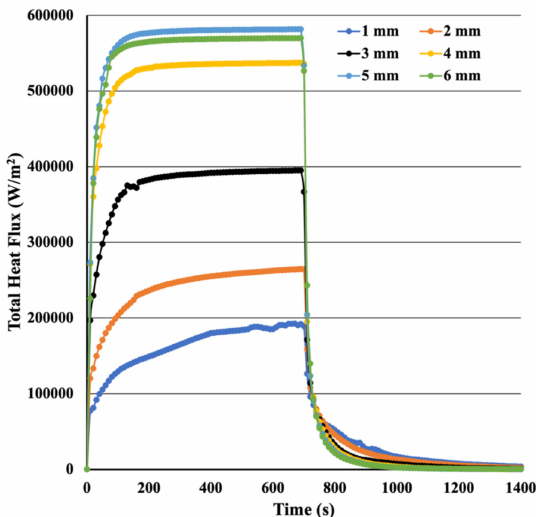
Figure 16. Total Heat flux during charging and discharging.